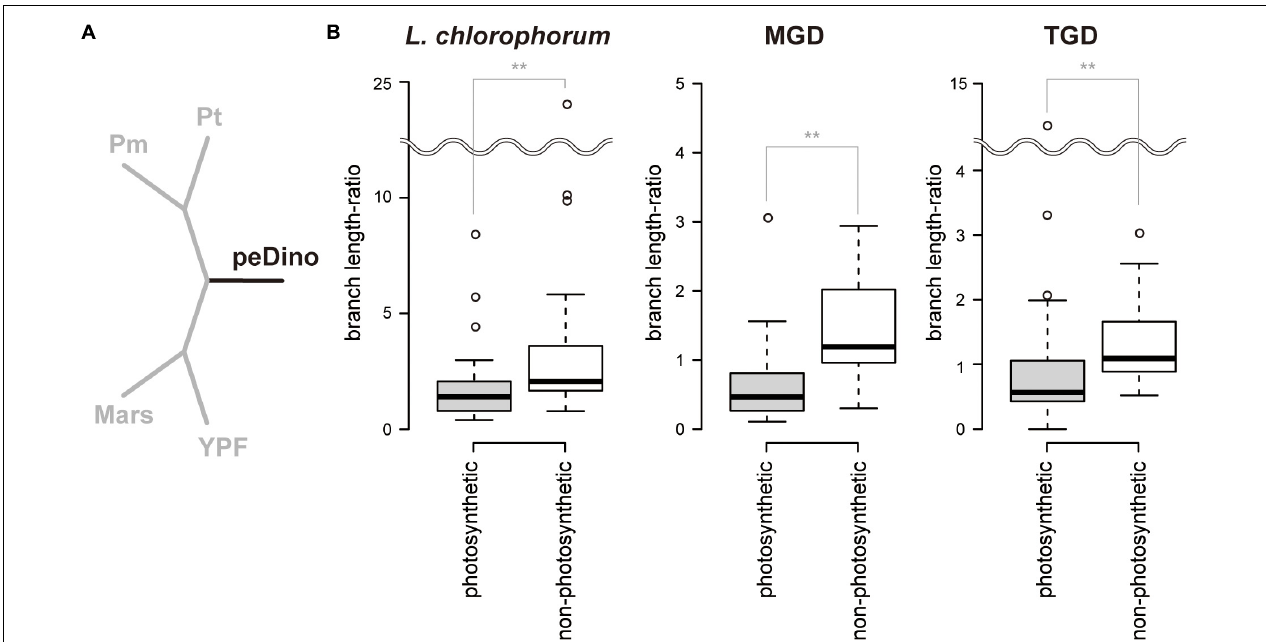
FIGURE 5 | Comparison of branch length between peDinoflagellates and pedinophycean green algae. (A) The 5-taxon tree. The branch lengths were optimized based on each of the 50 single-protein alignments. We fixed the relationship among Pedinomonas minor (Pm), Pedinomonas tuberculata (Pt), Marsupiomonas sp. (Mars), Pedinophyceae sp. YPF-701 (YPF), and one of the three peDinoflagellates (peDino). For each tree with the optimum branch lengths, the length of the black branch was subtracted by the sum of the lengths of the grey branches (“branch length-ratio”). (B) Box plots of branch length-ratios between 30 “photosynthetic” proteins and 20 “non-photosynthetic” proteins. The ratios calculated based on the 5-taxon trees considering Lepidodinium chlorophorum , strain MGD, and strain TGD are shown left, center, and right, respectively. Wilcoxon rank-sum test rejected the null hypothesis of no difference in the median values of branch length-ratios calculated from the two categories was rejected with p < 0.01 (highlighted by double asterisks). The 5-taxon trees with the optimum branch lengths and branch length-ratios are provided as Supplementary Material .